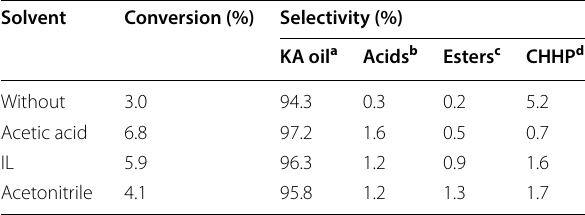
Table 1 Catalytic oxidation of cyclohexane over VAlPO